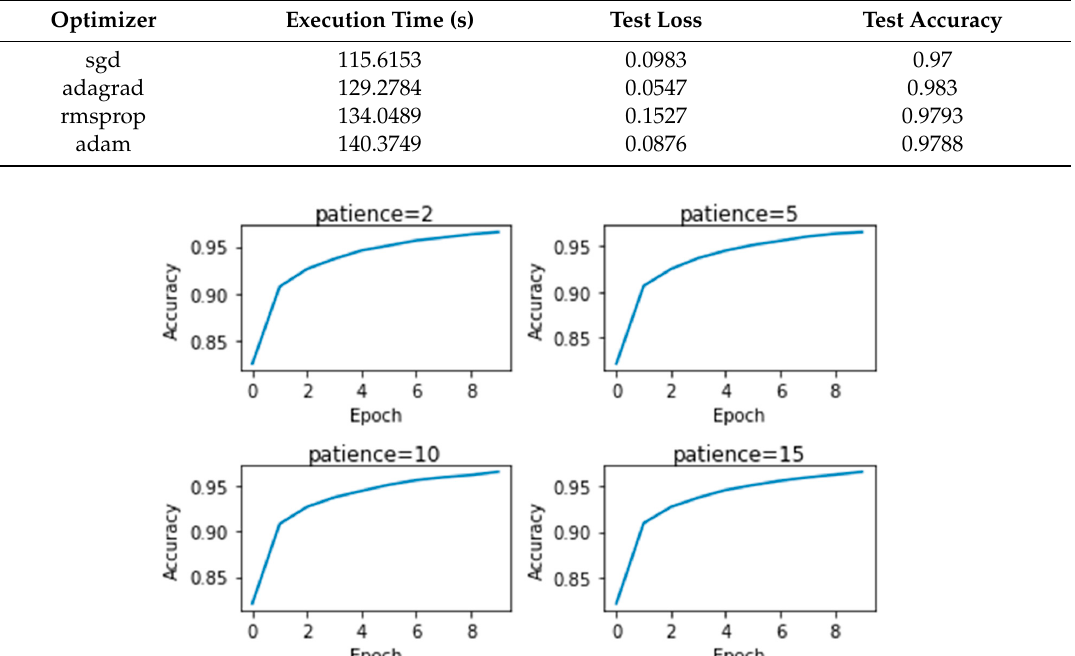
Figure 5. E ff ect of patience value on MLP. Figure 5. Effect of patience value on MLP.